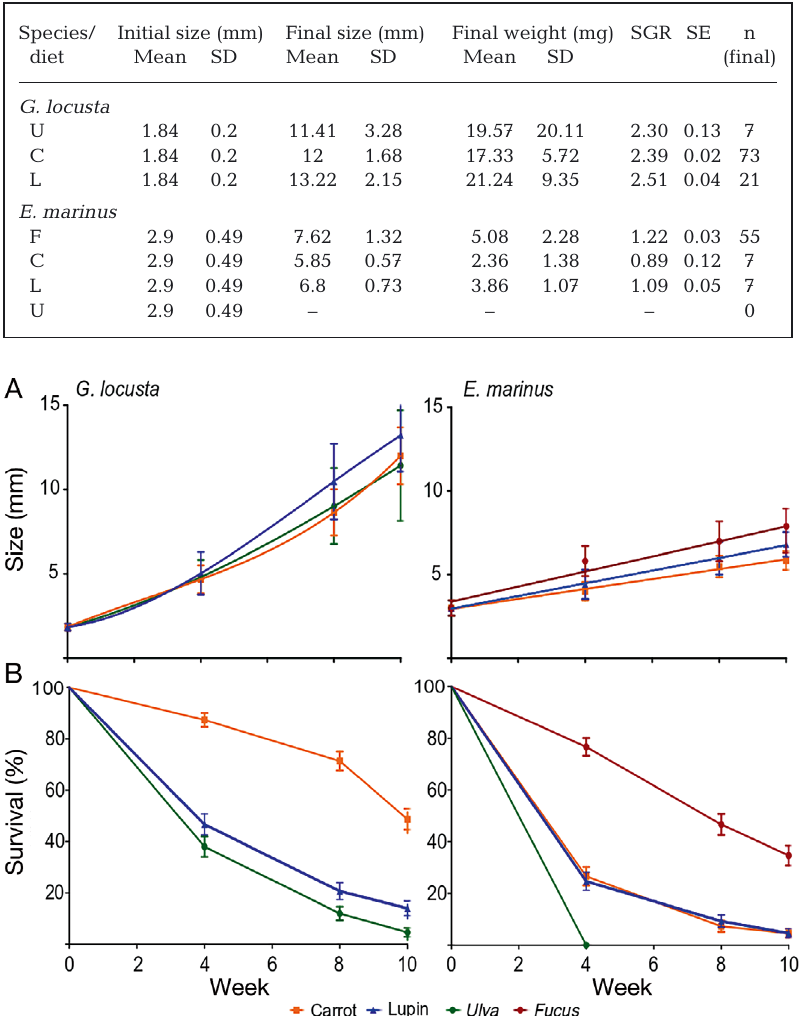
Fig. 1. (A) Growth and (B) survival rates of Gammarus locusta and Echinogam- marus marinus raised on different